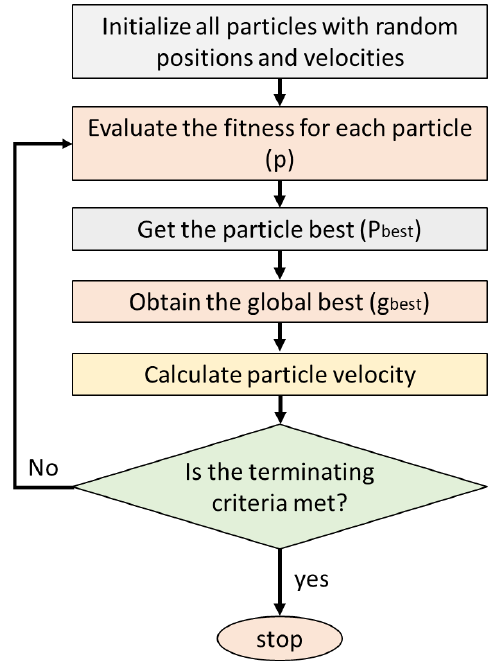
Figure 2. The algorithm of particle swarm optimization (PSO) (after Moayedi, et al. [46]).